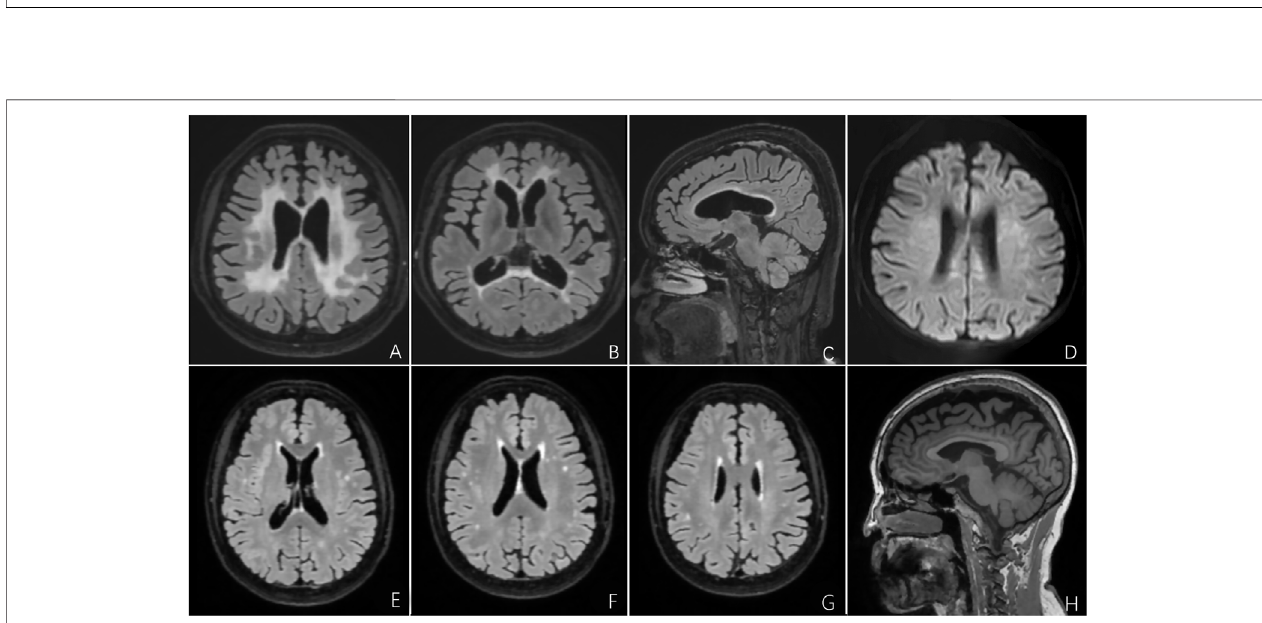
FIGURE8| BrainMRIoftheprobandandhermotherwithCSF1R-microglialencephalopathyinthesecondfamily.Bilateralcon fl uentanddiffusedeepwhitematter hyperintensities involving periventricular areas, corona radiate and the corpus callosum on the FLAIR imaging (A , B) and DWI (D) . Sagittal brain FLAIR shows abnormal hyperintensities and thinning of the corpus callosum, and extensive cortical atrophy (C) . Bilateral con fl uent deep white matter hyperintensities involving periventricular areas, corona radiate and the trunk of corpus callosum on the FLAIR imaging (E – G) . Sagittal brain T1-weighted imaging shows signi fi cant thinning of the corpus callosum, and extensive cortical atrophy (H)